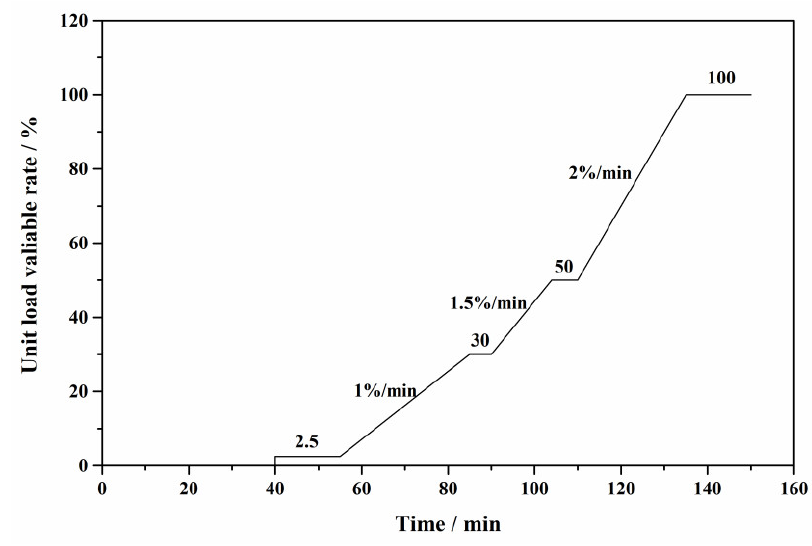
Figure 9. Predicted maximum load variable rate for a USC-CFB unit.